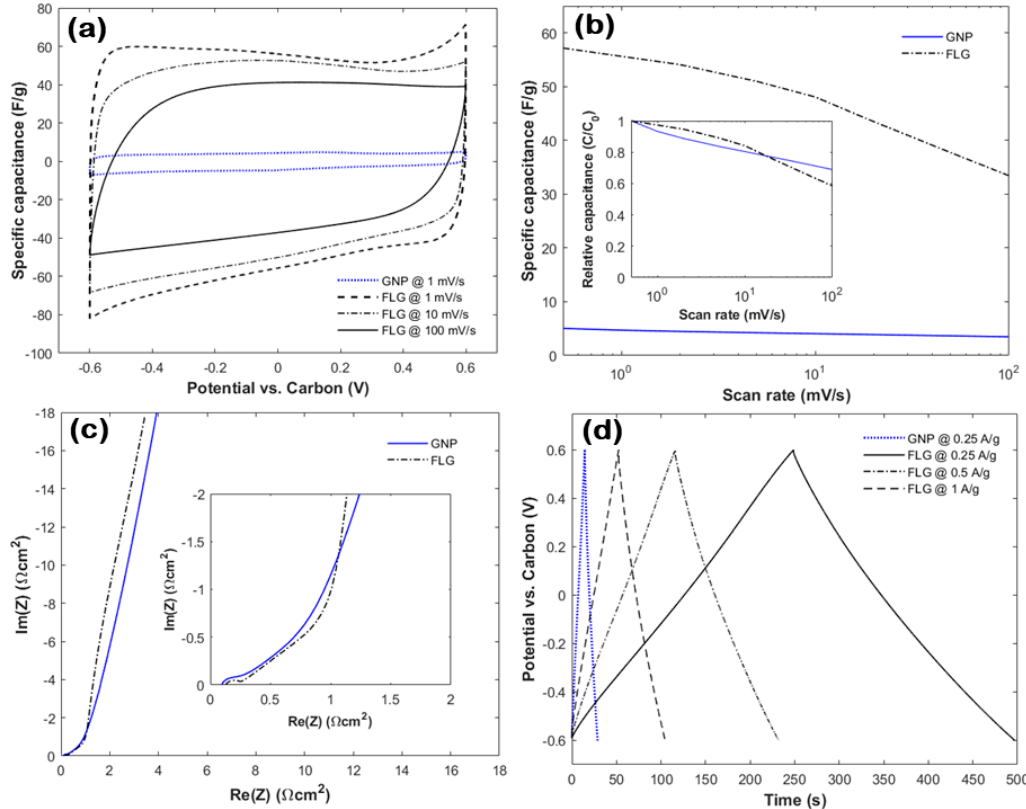
Figure 5. Electrochemical characterization of the FLG and GNP powders based on ( a ) CV curves with different scan rates (1, 10 and 100 mV/s), ( b ) rate handling tests between 0.5 and 100 mV/s based on CV, ( c ) Nyquist plots of the impedance spectra and ( d ) GCD curves for different specific currents (0.25, 0.5 and 1 A/g).